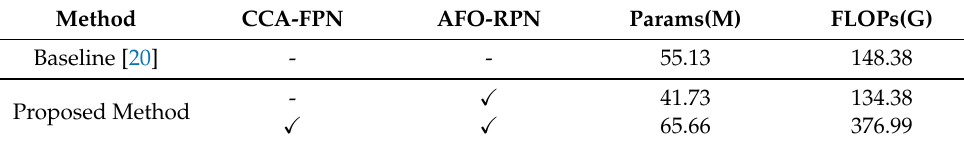
Table 5. Evaluation results with the parameters and computational complexity.